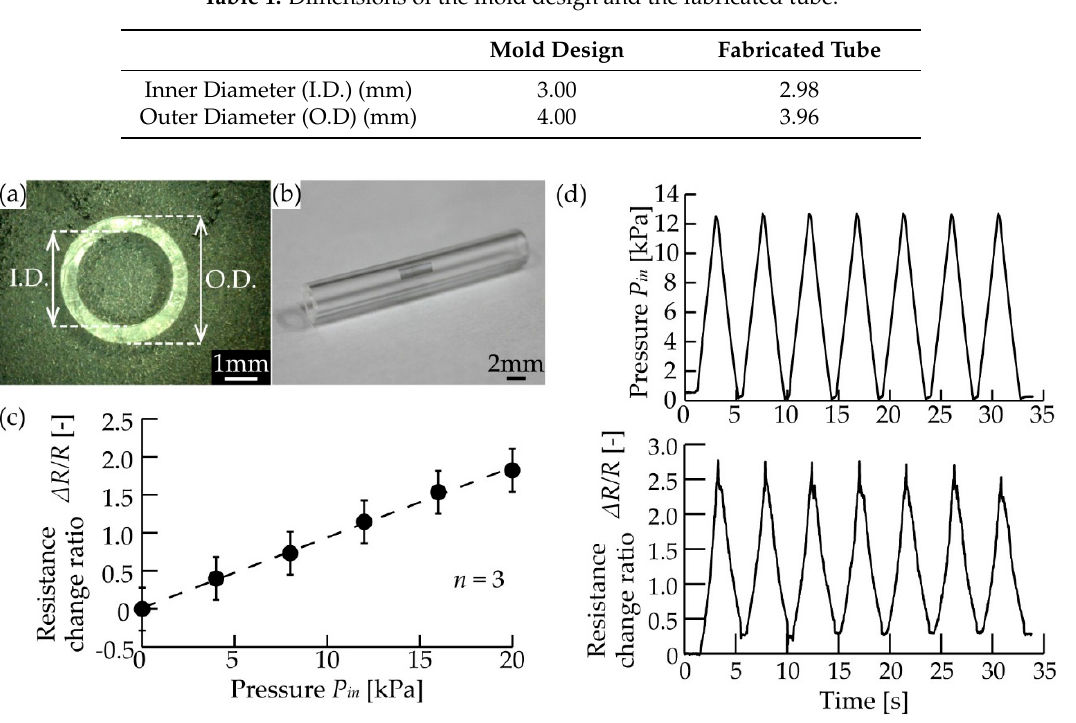
Figure 5. The fabricated pressure sensor. ( a ) Cross-sectional image of the PDMS tube. ( b ) Photograph of the PDMS tube with the transferred graphene. ( c ) The relationship between the applied pressure and the resistance change ratio of transferred graphene with three independent sensors. Error bars indicate standard deviation ( n = 3). ( d ) The relationship between the applied cyclic pressure and the resistance change ratio of the transferred graphene.